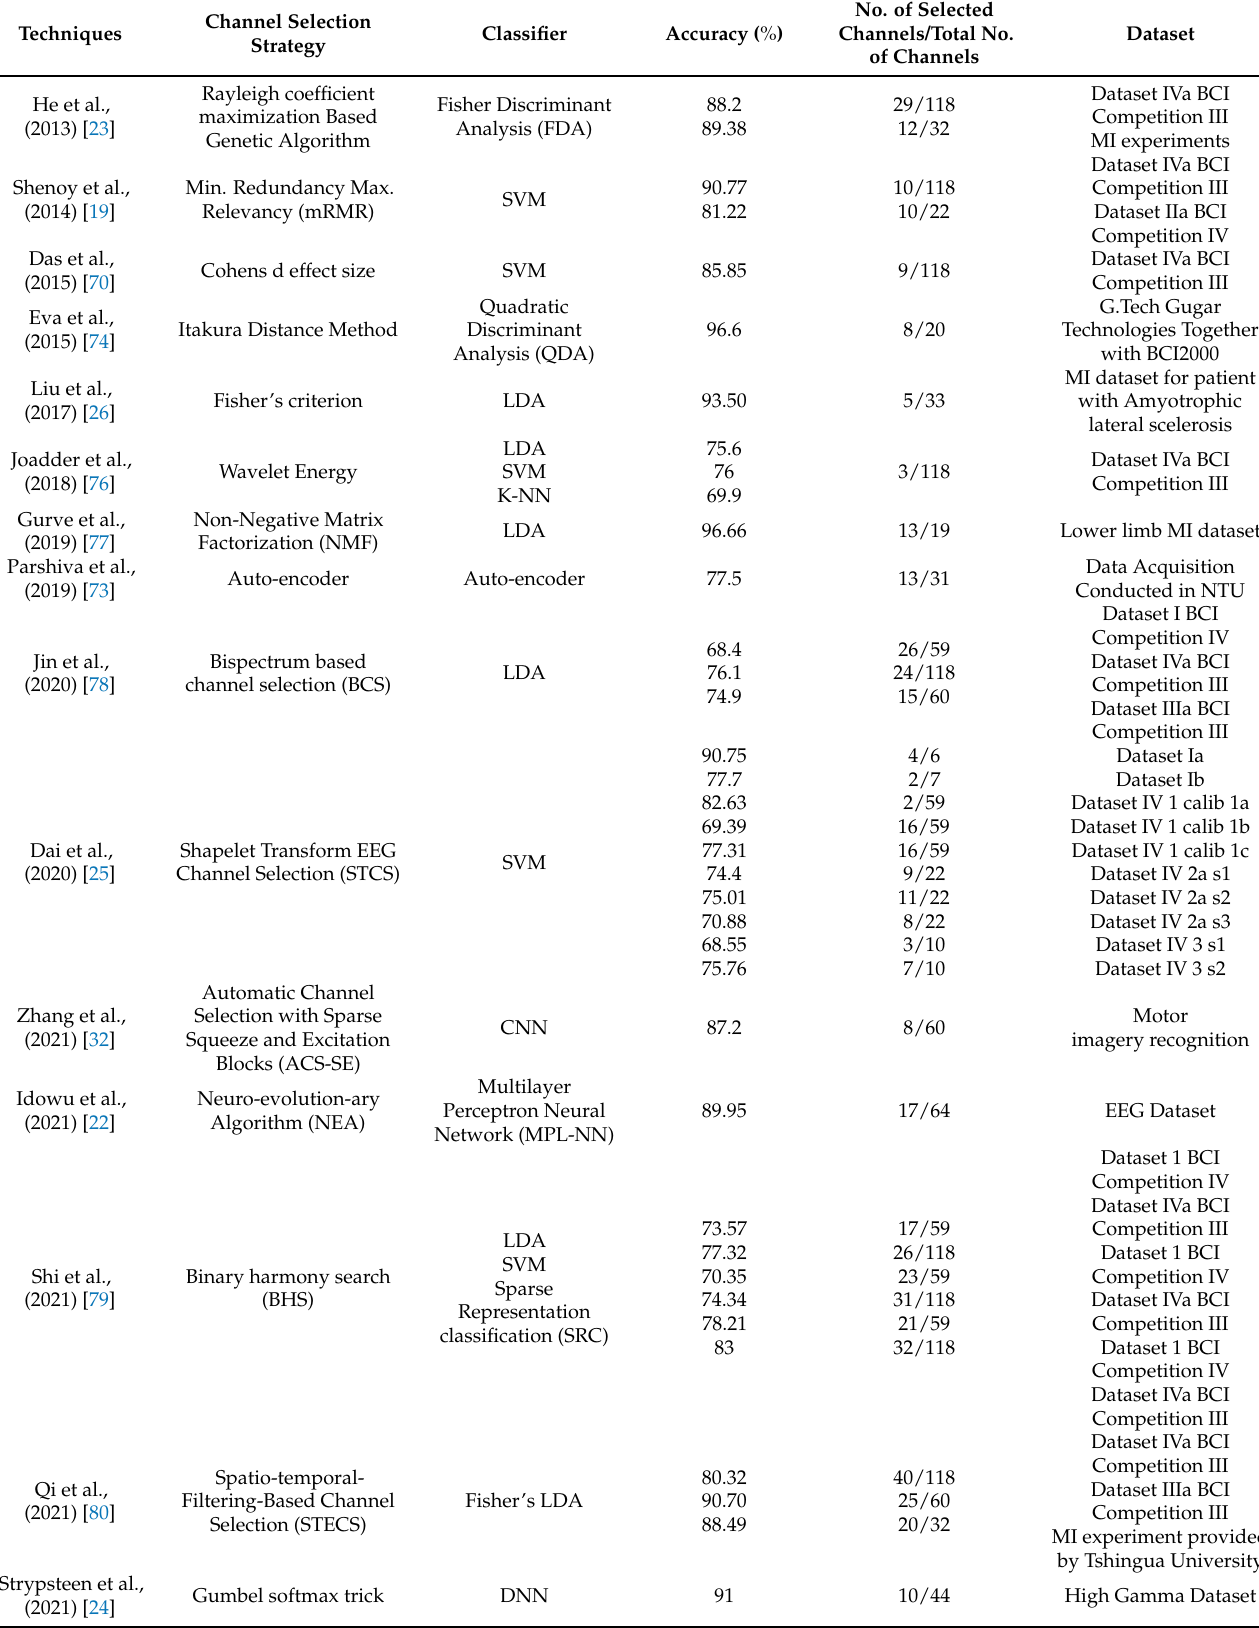
Table 6. Other techniques for motor imagery EEG channel